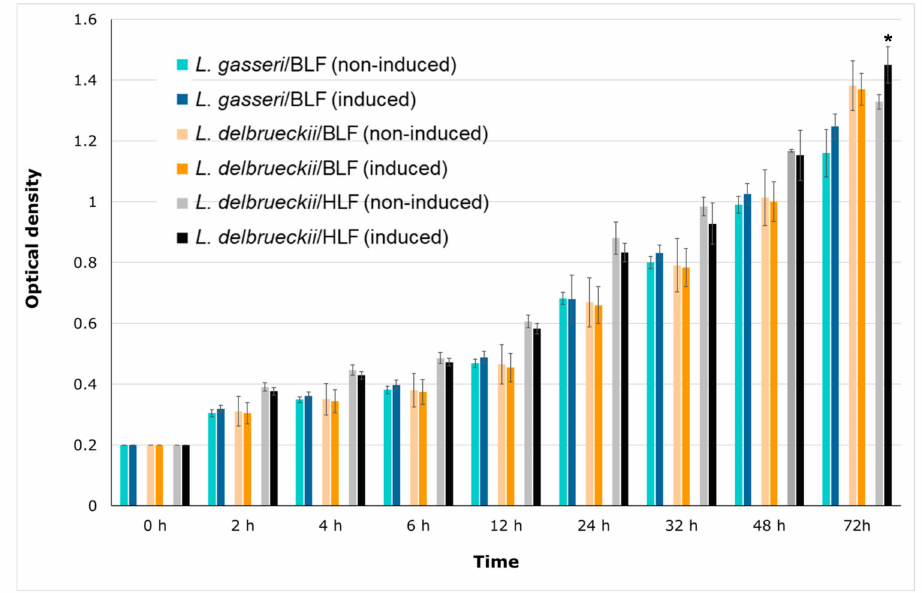
Figure 8. Effects of recombinant human or bovine lactoferrin on the growth of three recombinants: L. gasseri /BLF, L. delbrueckii/ HLF, and L. delbrueckii /BLF. The recombinant probiotic strains were grown in deMan–Rogosa–Sharpe (MRS) broth to an optimal optical density at 600 nm (OD 600 ) of 0.2. Then, theses bacteria were cultured in MRS medium with and without nisin-induced expression of recombinant human or bovine lactoferrin. The growth responses of each bacterium were measured by determining the optical density at different time intervals at room temperature (approximately 23–25 ◦ C). The results are expressed as mean ± standard deviation and variations in growth curves of probiotic bacteria with and without nisin induction. * Significant differences in the probiotic growth with and without nisin induction ( P <